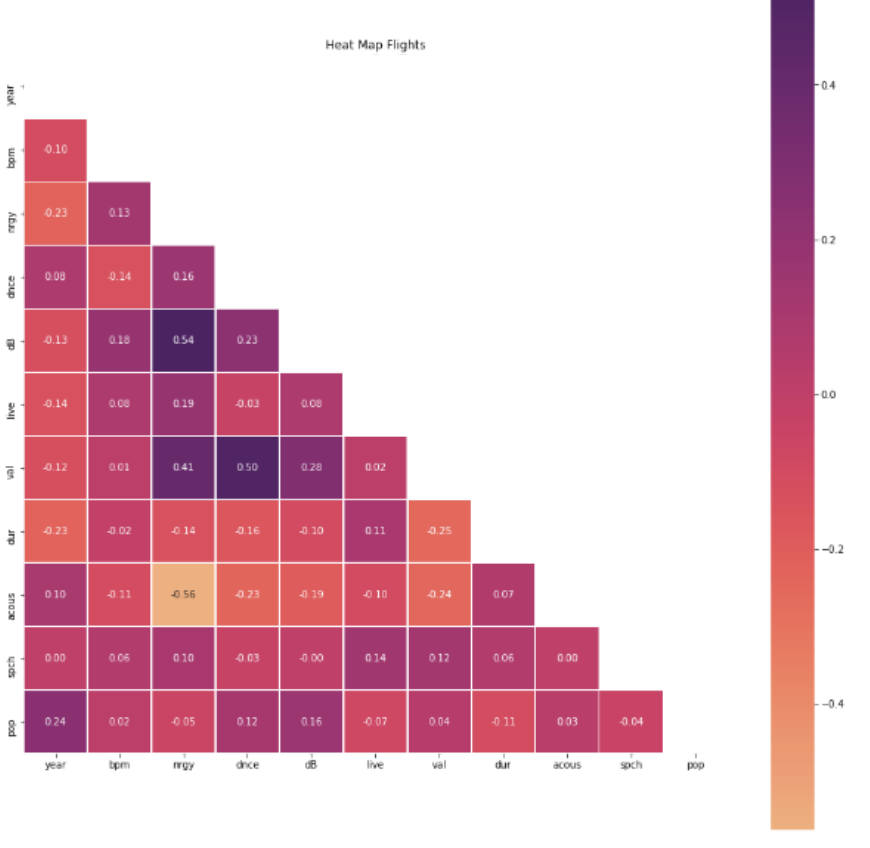
Figure 7. Cluster map representing the correlation between different features of the